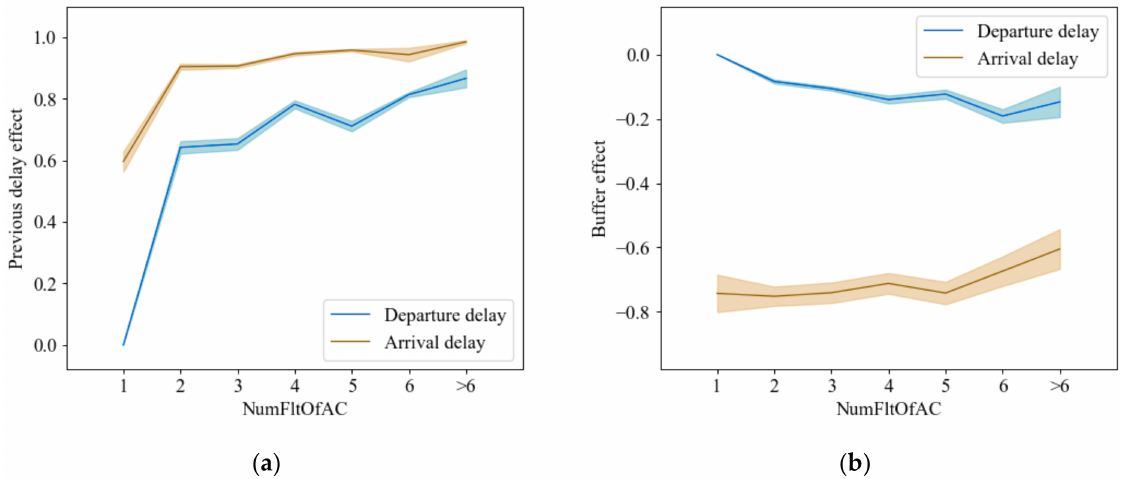
Figure 3. Delay propagation effect variation with OrdFltOfAC. ( a ) Previous delay effect against OrdFltOfAC. ( b ) Buffer effect against OrdFltOfAC.